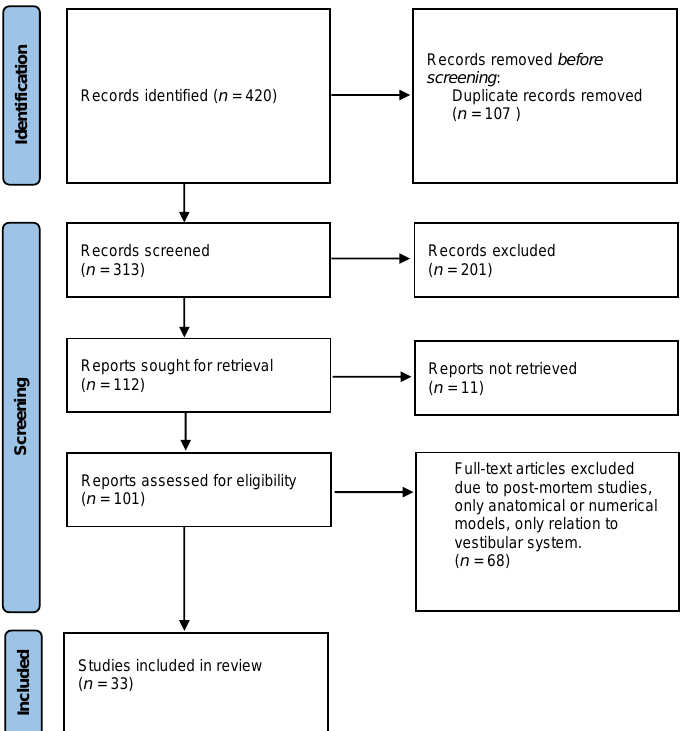
Figure 1. Flow chart of the study selection procedure.